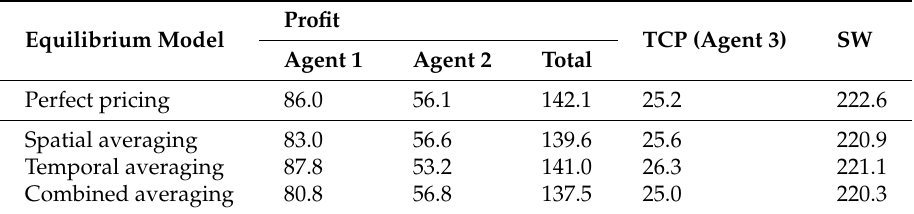
Table 4. Case study: profits and social welfare ($ thousand) for a perfect pricing and three imperfect pricing cases (Max SW EPEC).